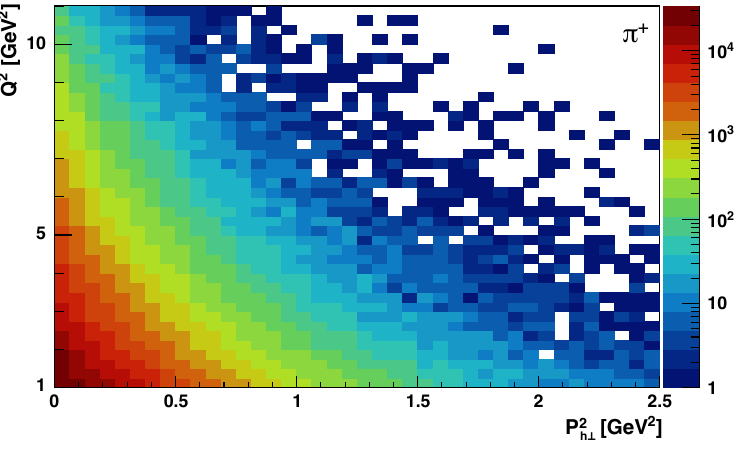
Figure 6 . Distribution in Q 2 versus P 2